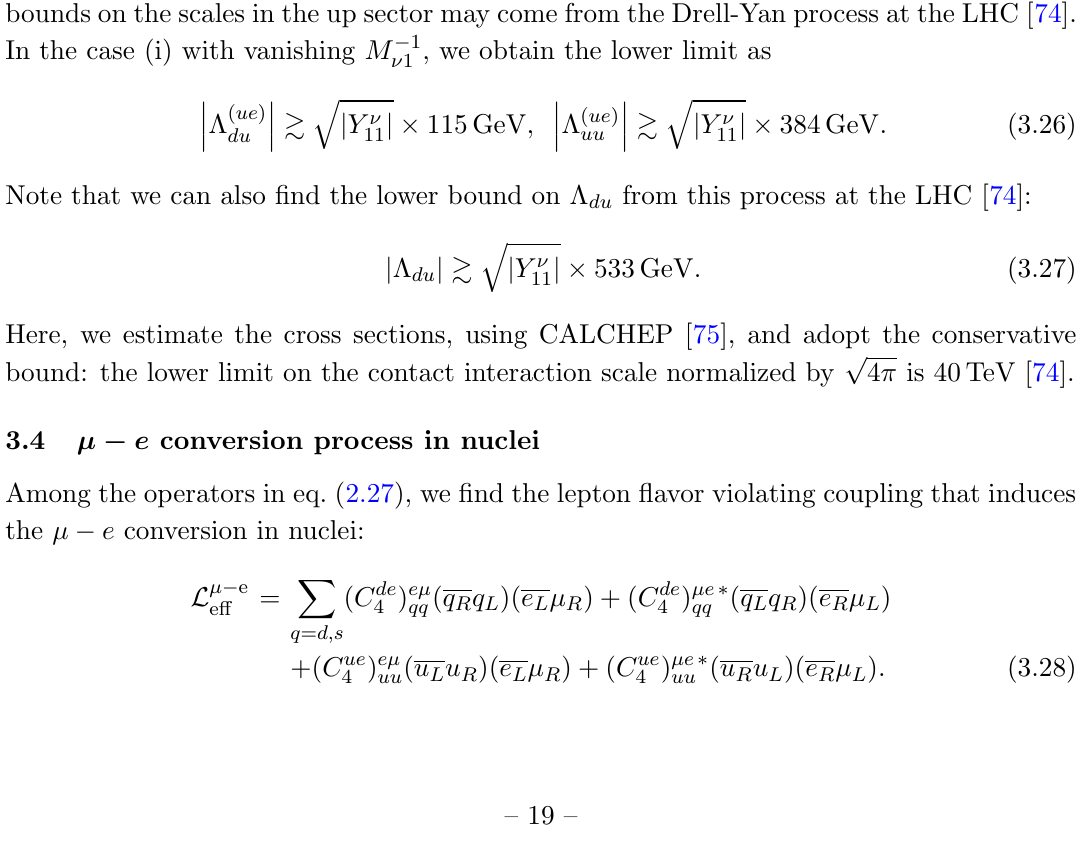
Figure 4 . The deviations of Br ( B d ! (cid:22)(cid:22) ) (left) and Br ( B s ! (cid:22)(cid:22) ) (right) in our model. The thick and dashed blue lines depict our predictions in the case with j Y (cid:23) SM predictions of Br ( B q ! (cid:22)(cid:22) ) using our input parameters are depicted by the dashed black lines with the gray band, taking into account the errors of the form